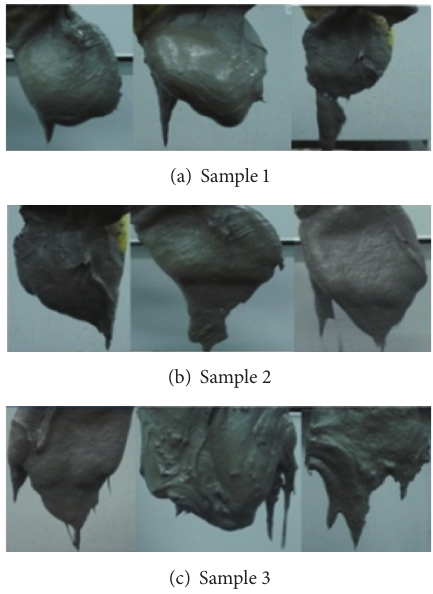
Figure 7: New cement grout just added accelerator.